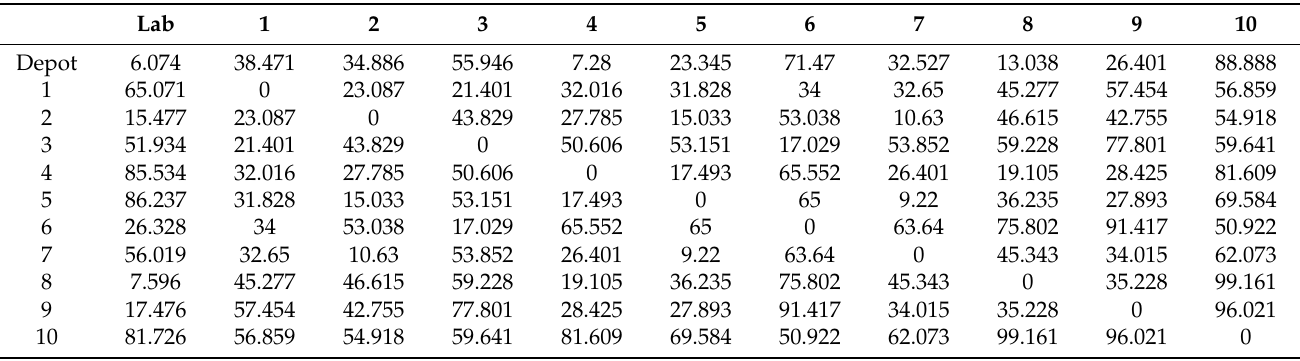
Table A2. Sample traveling times between the places of the patients for the first category